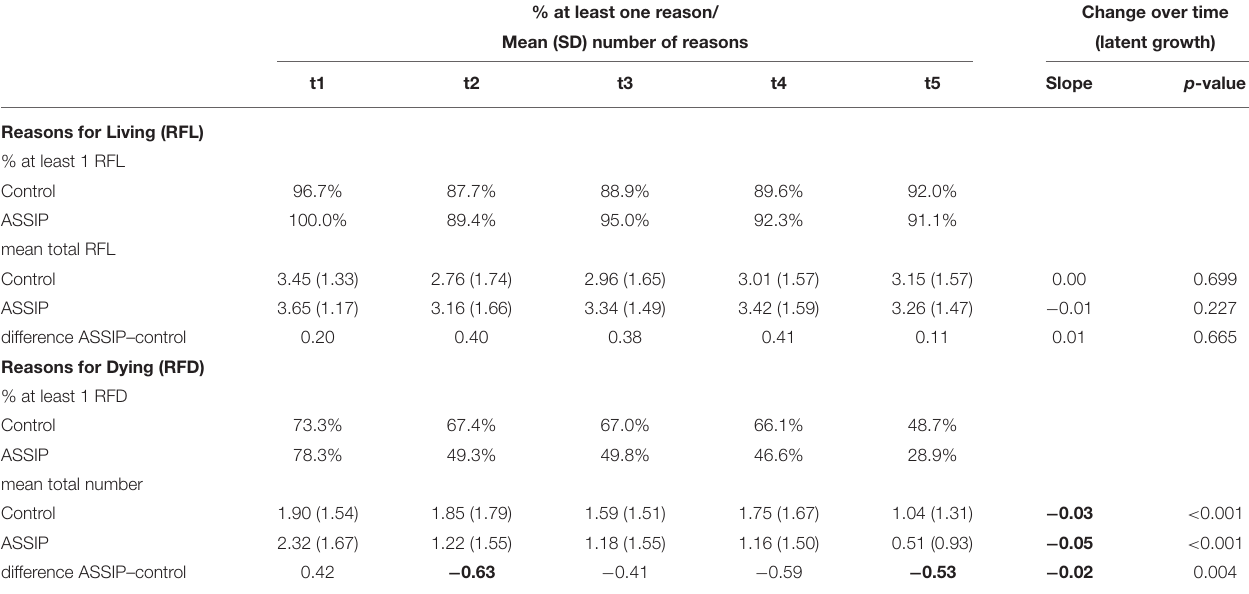
TABLE 2 | Development of number of RFD/RFL over